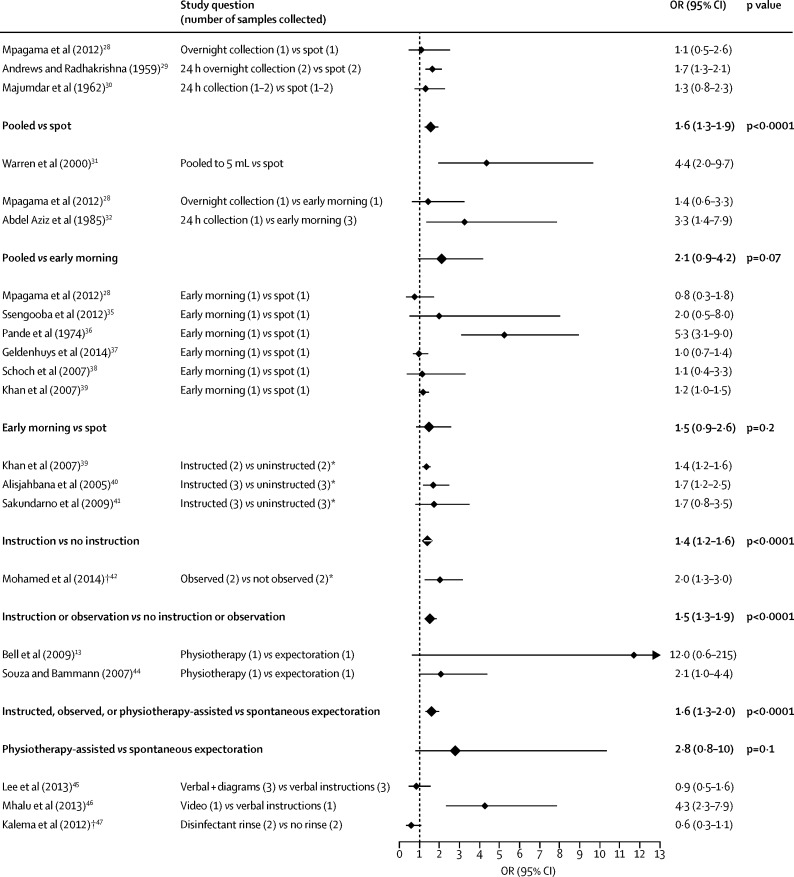
Forest plot of both individual and combined meta-analysis results for smear microscopy*Samples collected in both comparison and reference group were a combination of spot and early morning samples. †Odds ratio (OR) was calculated from individual patient-level data and not from sputum sample-level data. Comparisons in bold typeface and a larger diamond symbol indicate the results of a pairwise meta-analysis.